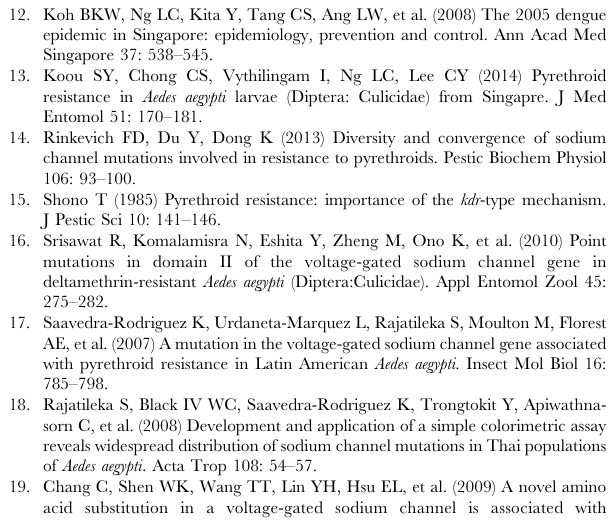
Figure S1 Diagram depicting primer positions. Figure S2 Multiple alignments of CYP9M6 cDNA sequences identified from SP and SMK strains of Aedes aegypti . Hyphens indicate identical nucleotides to the sequence of CYP9M6v1 (SP). CYP9M6v1 and v2 are identified from SP strain. CYP9M6v3 , v4 , and v5 were identified from SMK strain. Primers used for